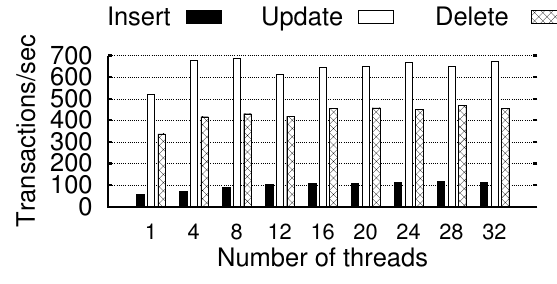
Figure 13. SQLite operation with multi-thread on internal eMMC. sync mode: FULL; journal mode: DELETE [Samsung Galaxy S4, Android 4.2.2 (JB), /data partition,